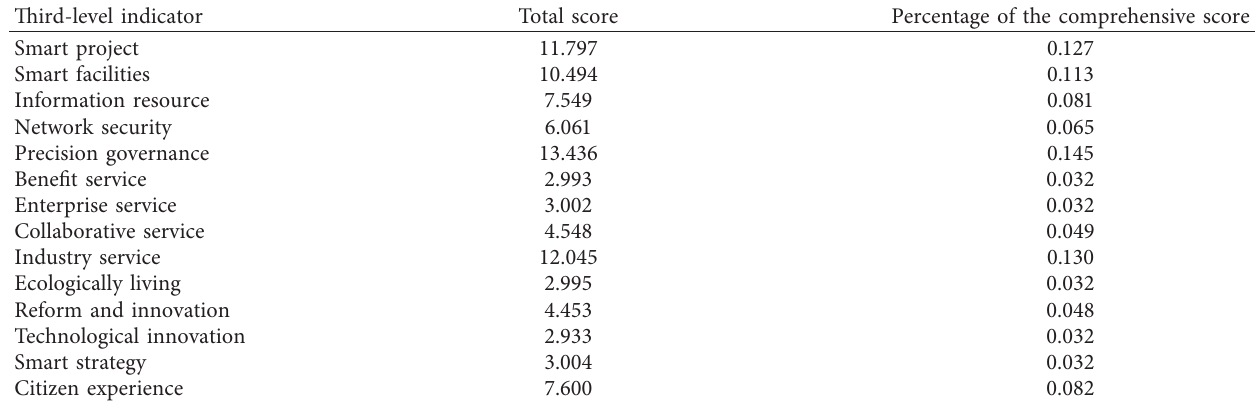
Table 9: Percentage of third-level indicators to comprehensive